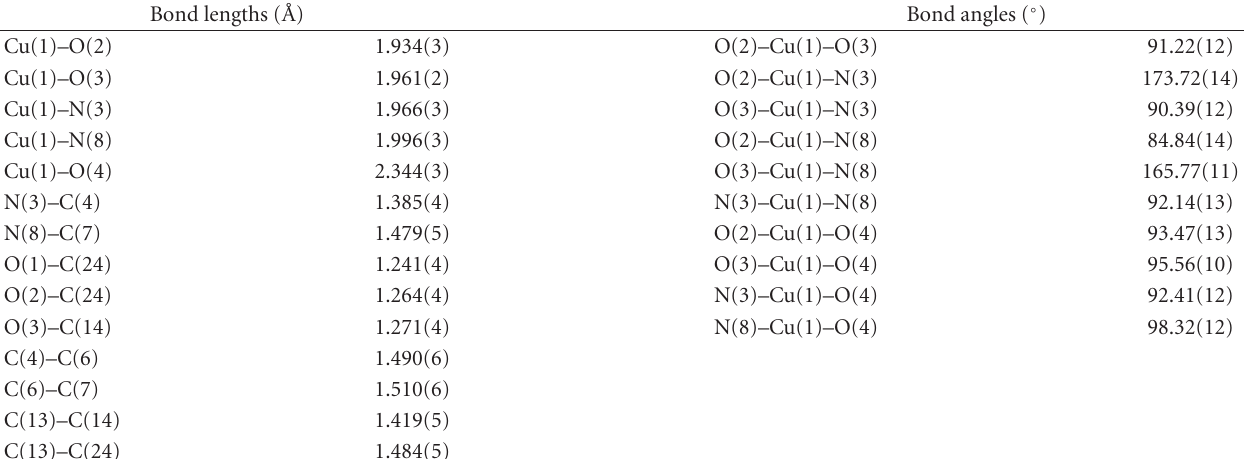
Table 1: Selected bond lengths (˚A) and bond angles ( ◦ ) for [Cu(hsm)(nal)H 2 O]Cl · 3H 2 O.